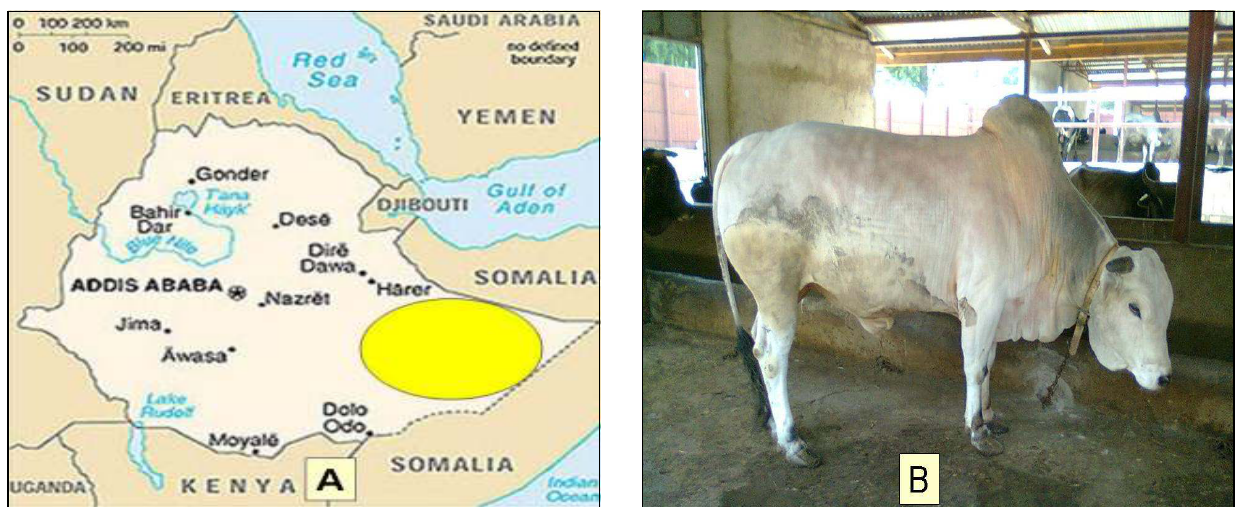
Figure-1: A. The Ogaden region marked in yellow; B. Ogaden bull at Haramaya farm